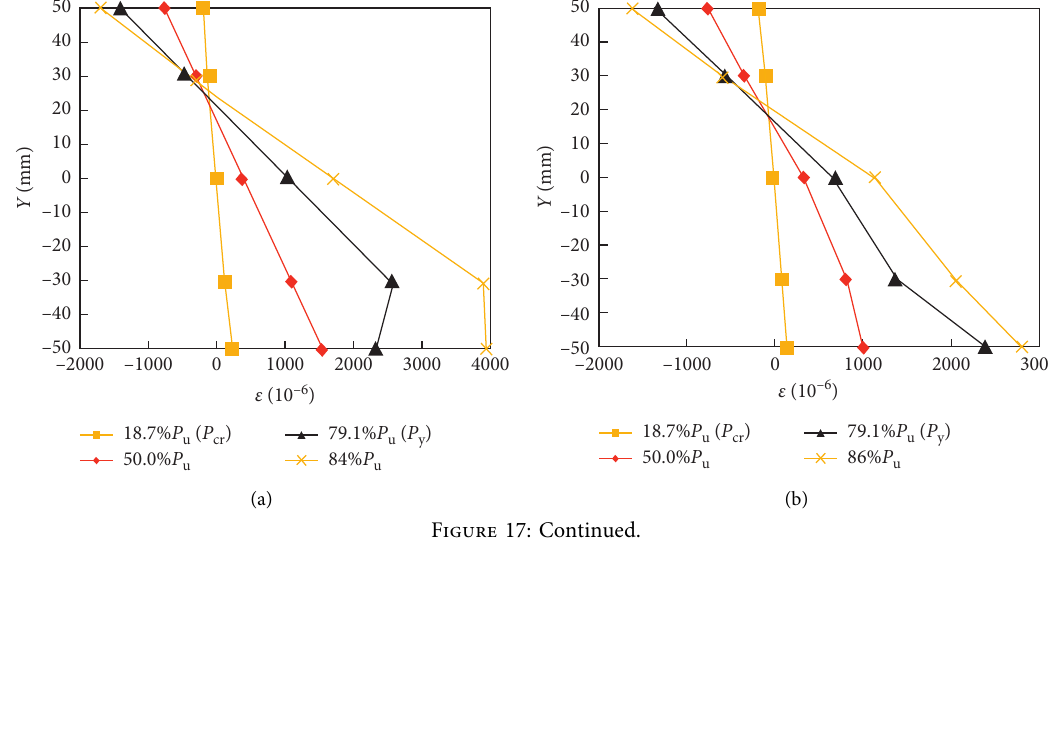
c ) as well as steel faceplate ( ε p ) versus midspan deflection curves for HSC1-1.